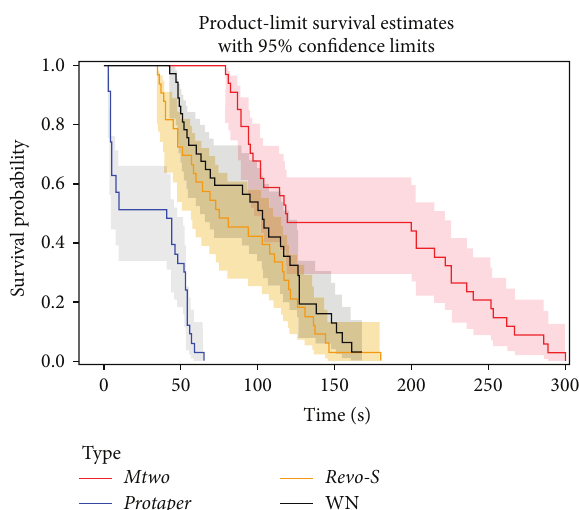
Figure 3: The Kaplan-Meier estimate of the survival function (probability of cyclic resistance) of rotary instruments categorized by the type of rotary instrument.